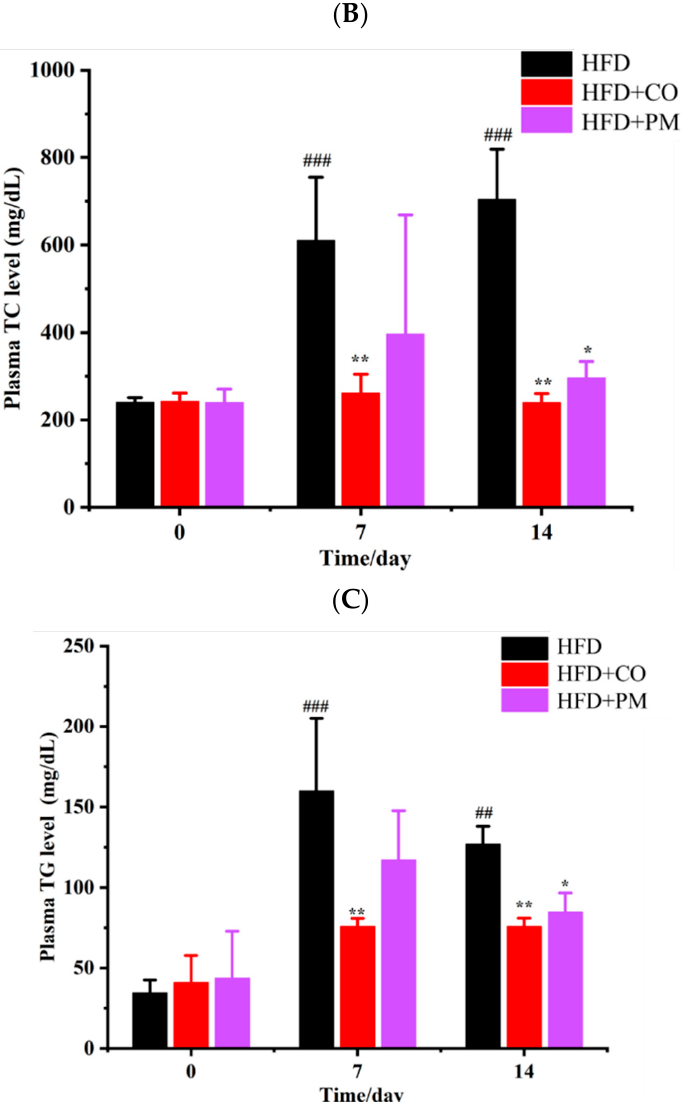
Figure 9. The plasma lipid-lowering effects of the CO and PM. ( A ) The mice body weight. ( B ) The plasma cholesterol levels of mice. ( C ) The plasma triglyceride levels of mice. * p < 0.05, ** p < 0.01, compared with the model group on the equal day; ## p < 0.01, ### p < 0.001, compared with the HFD model group on day 0.